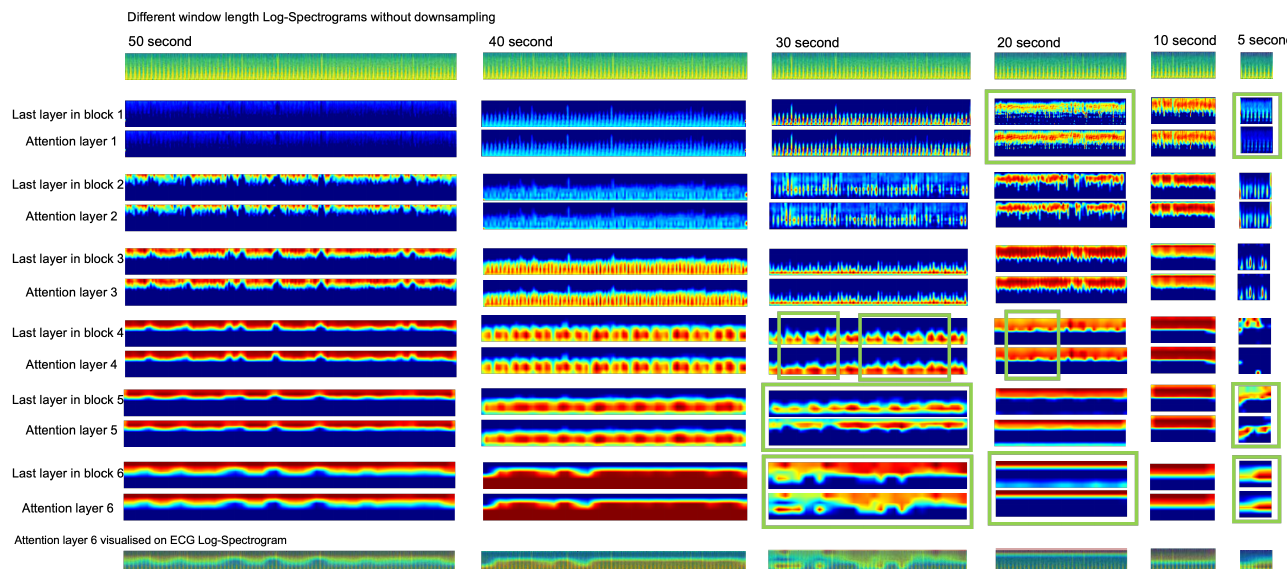
Figure 8. Examples of visual explanations of the features in the last layer of each convolutional block and each attention layer of the proposed method. The log-spectrograms without downsampling are the inputs of the proposed method. These log-spectrograms are generated from the 50 s, 40 s, 30 s, 20 s, 10 s and 5 s window lengths of raw ECG data. The green rectangle highlights the huge visual difference between the adjacent layers.